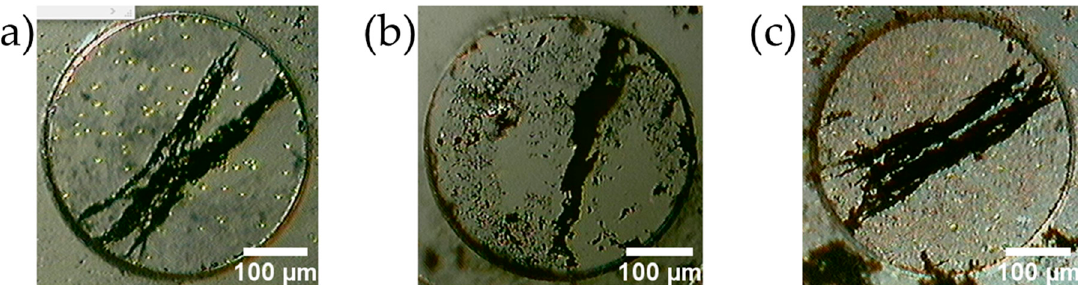
Figure 7. MMSBs in PDMS microwells ( 𝜙 400 μ m, depth 100 μ m). ( a ) MMSB made of neodymium magnet. ( b ) MMSB made of SUS304. ( c ) MMSB made of magnet sheet.